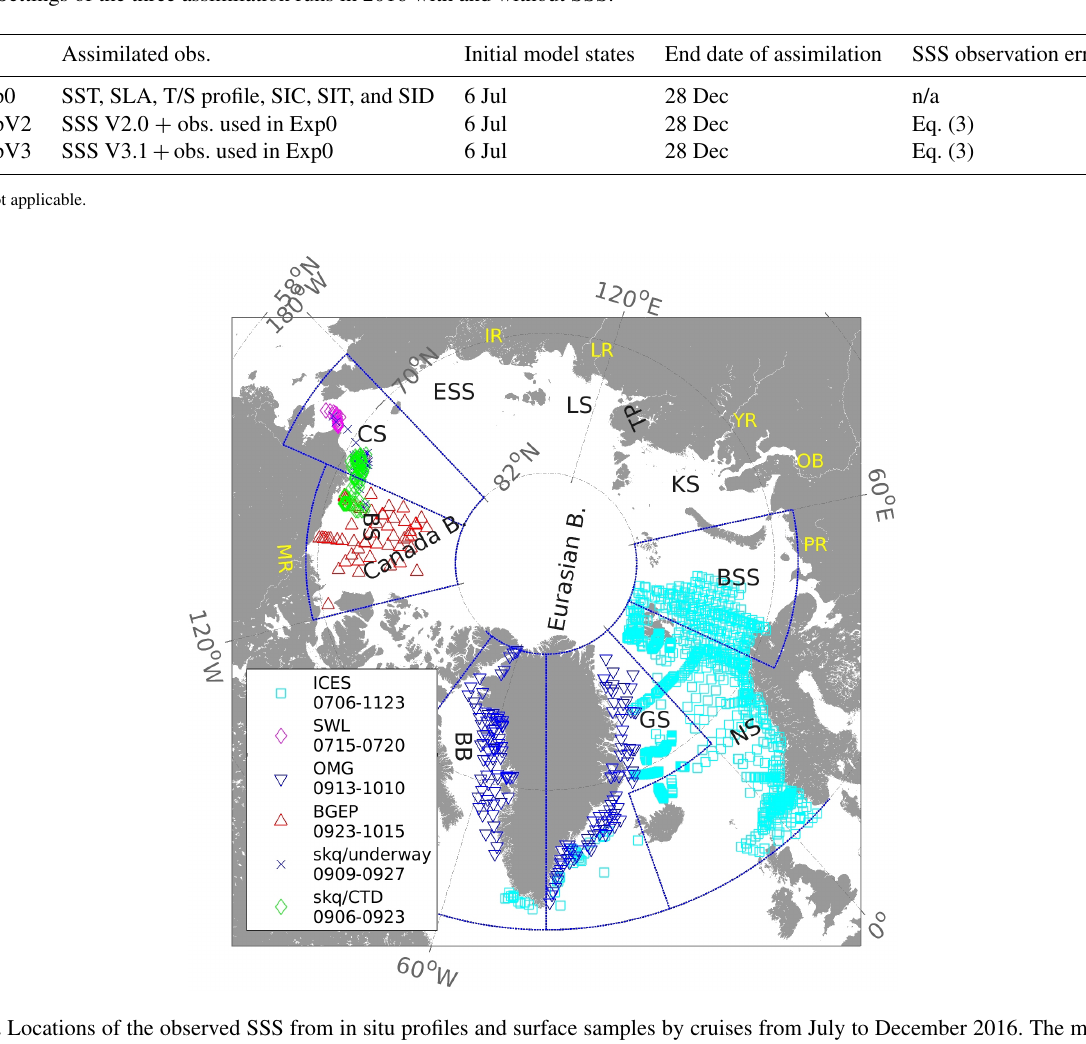
Figure 2. Locations of the observed SSS from in situ profiles and surface samples by cruises from July to December 2016. The marks note six observation sources; see the details in Sect. 2.3. The marginal seas delineated are the Beaufort Sea (BS), Chukchi Sea (CS), East Siberian Sea (ESS), Laptev Sea (LS), Kara Sea (KS), Barents Sea (BSS), Greenland Sea (GS), Norwegian Sea (NS), and Baffin Bay (BB). The main rivers around the Arctic region are the Mackenzie River (MR), Pechora River (PR), the Ob (OB), Yenisey River (YR), Lena River (LR), and Indigirka River (IR). TP indicates the Taymyr